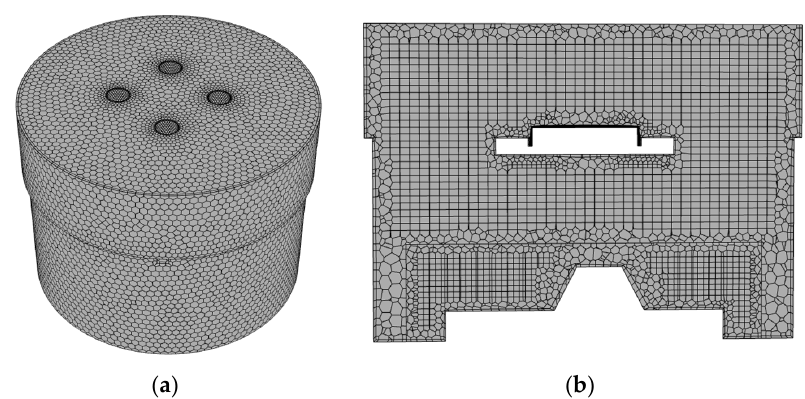
Figure 3. Computational mesh on the fluid domain with stirrer 1. ( a ) surface mesh. ( b ) section through the vessel.